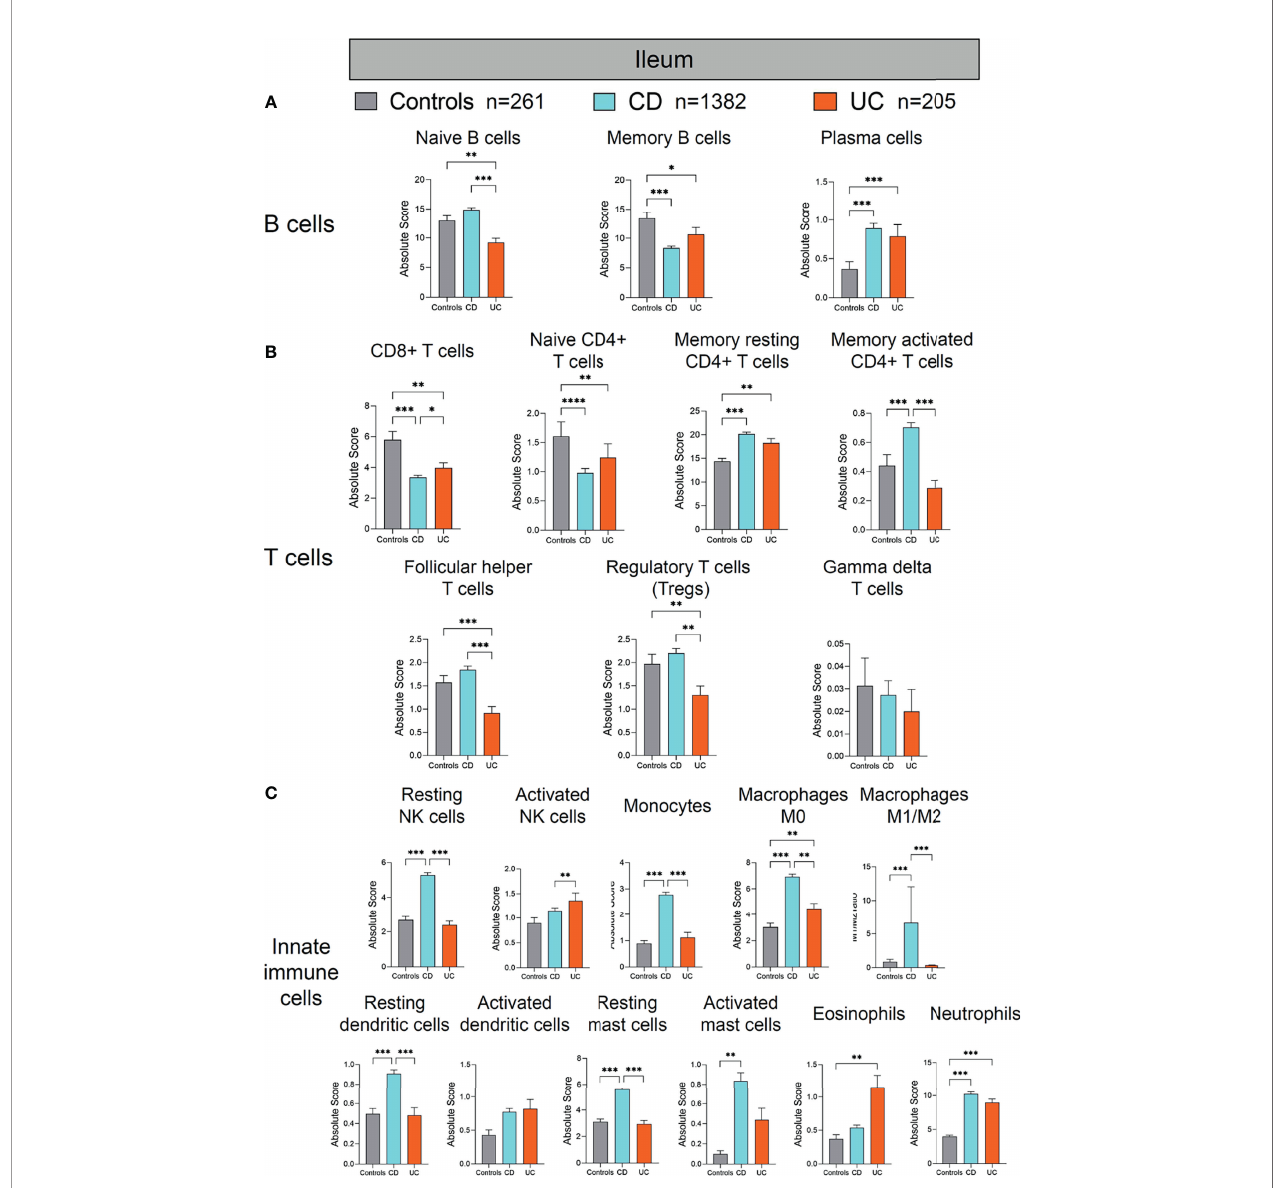
FIGURE 4 | Absolute quantity of immune cells pro fi ling in the ileum of patients with IBD and healthy individuals. (A) Comparisons of the B-cell subpopulations among three disease subtypes in the ileum. (B) Comparisons of the T-cell subpopulations among three disease subtypes in the ileum. (C) Comparisons of the innate immune cell subpopulations among three disease subtypes in the ileum. Statistical signi fi cance was determined by Kruskal – Wallis non-parametric test and Dunn ’ s multiple comparisons test. * p < 0.05; ** p < 0.01, *** p <